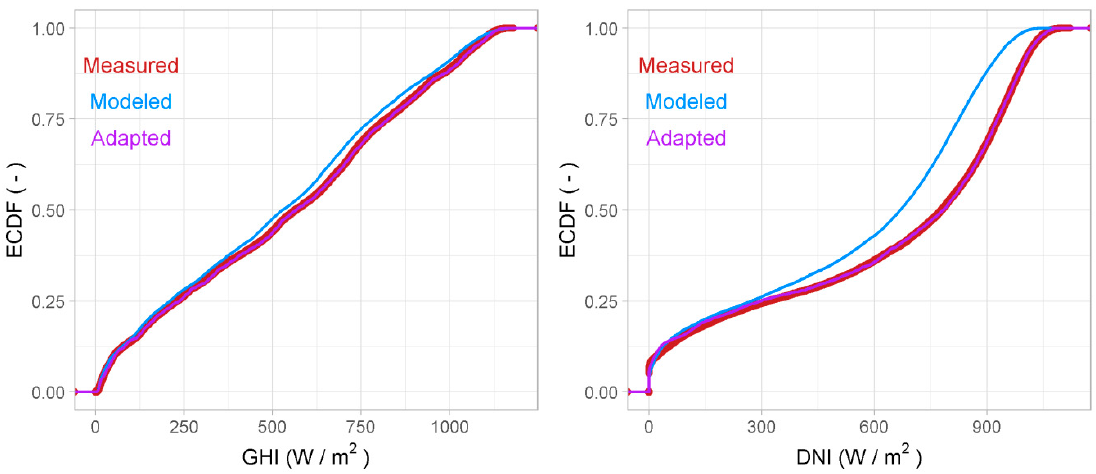
Figure 6. Empirical cumulative distribution function (ECDF) of daytime measured (red marker), modeled (blue line) and site-adapted (purple line) GHI (left) and DNI (right) at Gobabeb site using the year 2013 for the site-adaptation.